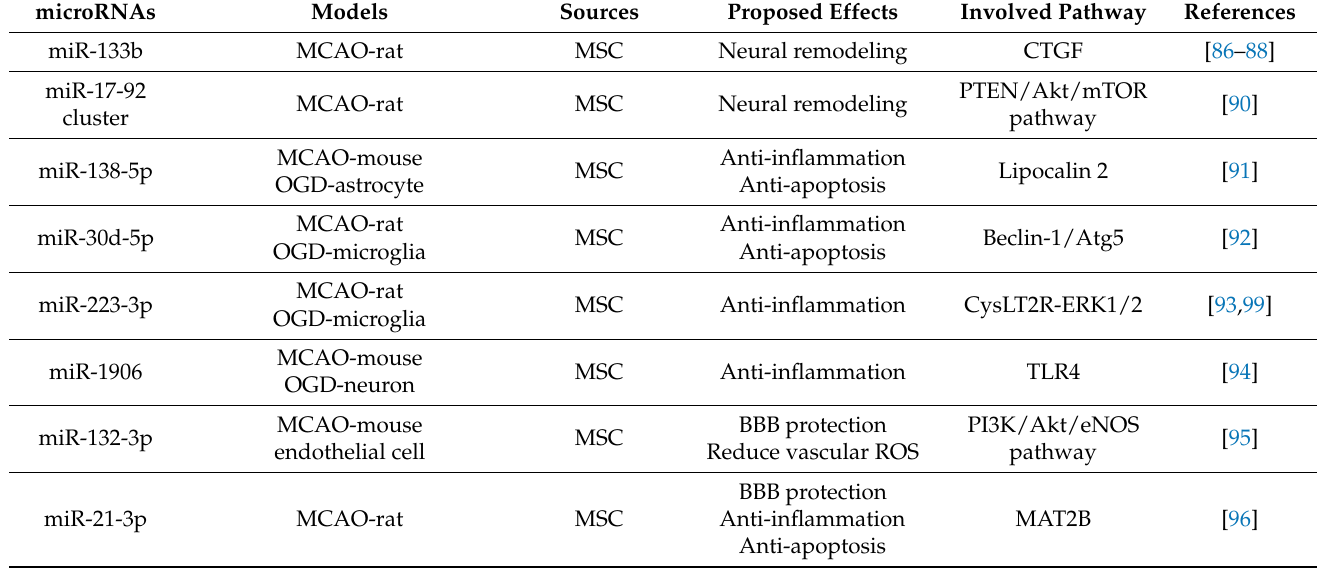
Table 2. Exosomal microRNAs have been Used to Treat Ischemic